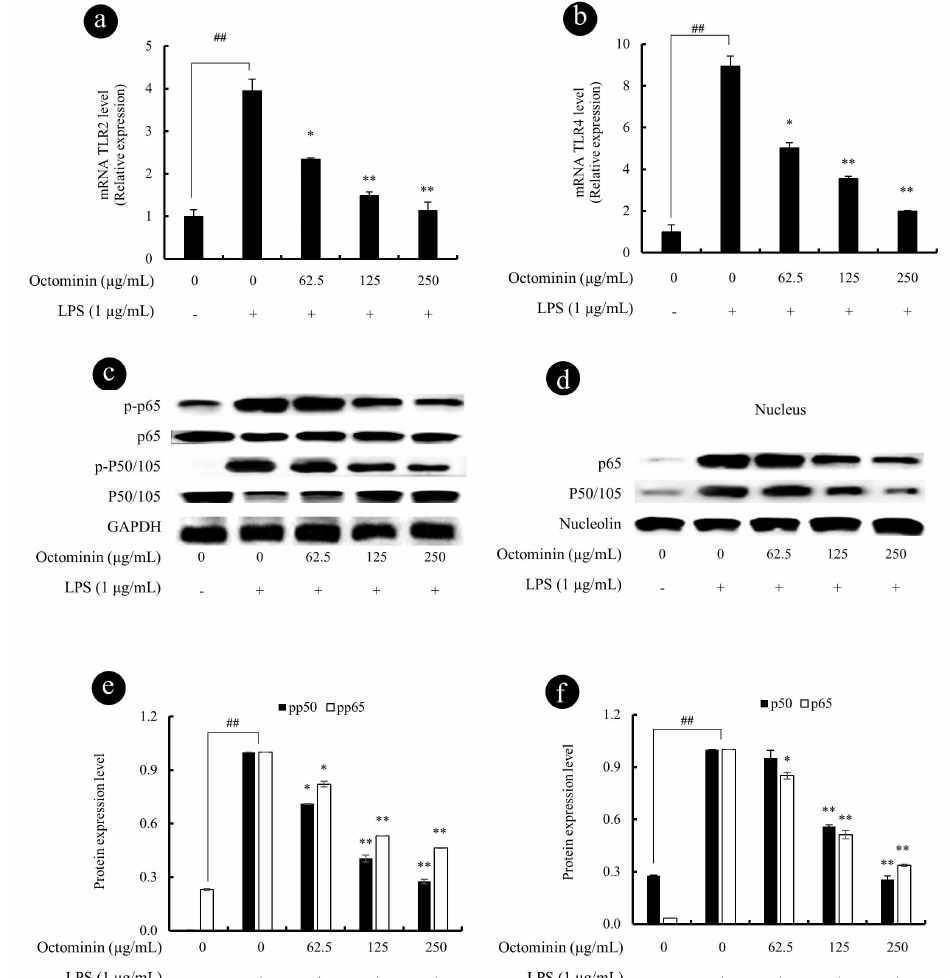
Figure 6. Octominin inhibits the LPS-induced inflammation in macrophages via blocking TLR4 / NF- κ B signal transduction. The gene expression analysis of TLR2 ( a ) and TLR4 ( b ) was measured using qPCR with GAPDH as the internal reference gene. The 2 − ∆∆ Ct method was used to calculate the relative mRNA expression levels. The translocation of NF- κ B p50 and p65 to the nucleus was analyzed by Western blot analysis of cytoplasmic ( c ) and nuclear ( d ) protein extracts. Equal protein loading was controlled using antibodies against β -actin and nucleolin in cytosolic and nuclear extracts, respectively. Relative expression of the bands was analyzed using ImageJ software ( e , f ). Results are expressed as the mean ± SD of three separate experiments. Statistical significance was determined versus vehicle-treated control group ( # < 0.05 and ## < 0.01) or LPS-treated group (* < 0.05 and ** <